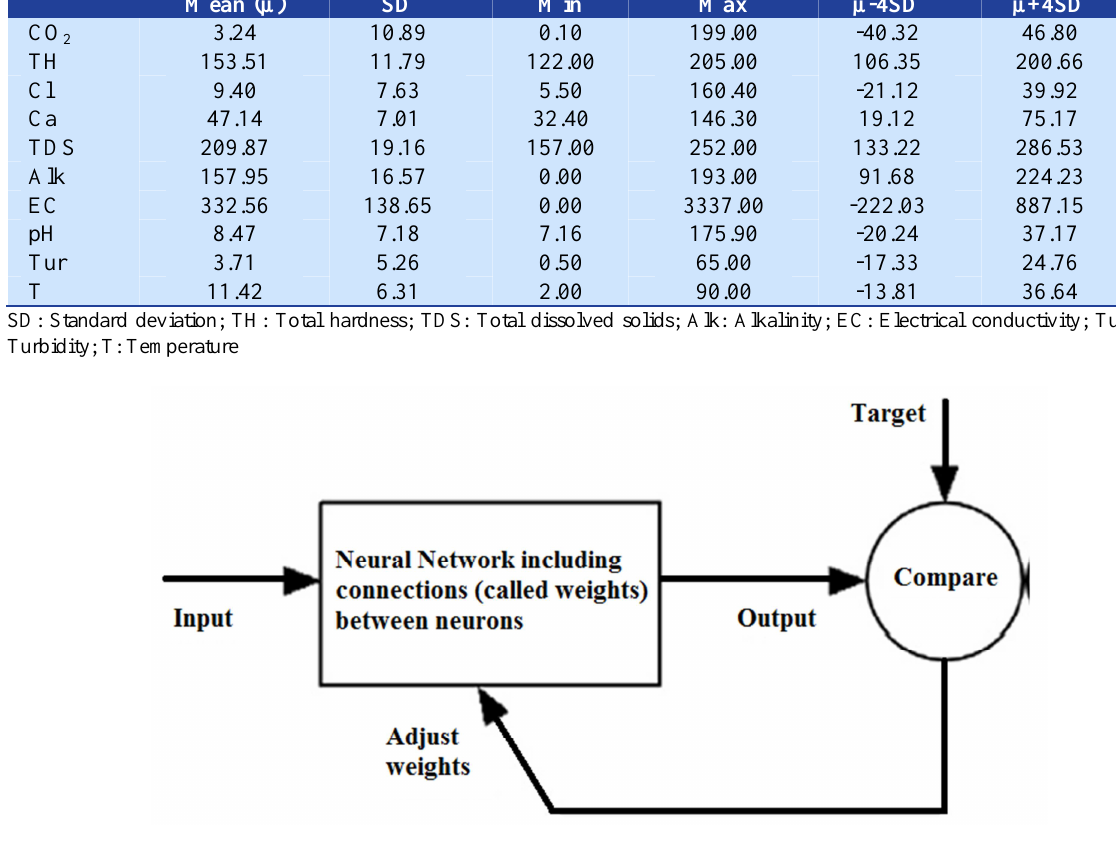
Figure 1. Neural network training